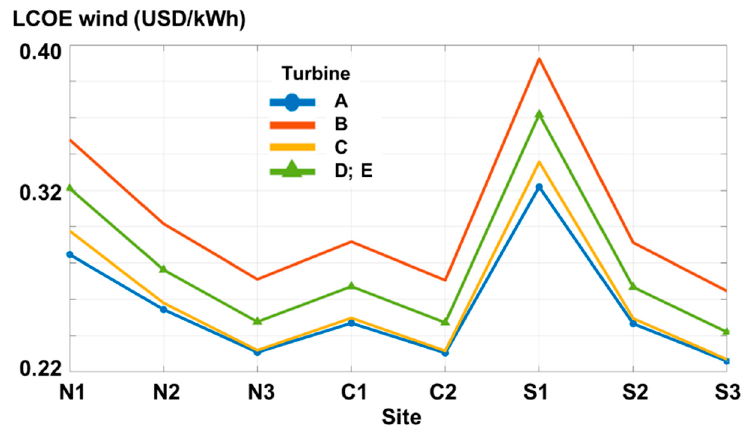
Figure 13. Levelized Cost of Energy (LCOE) estimated in the reference sites for all the wind turbines considered (A, B, C, D and E).